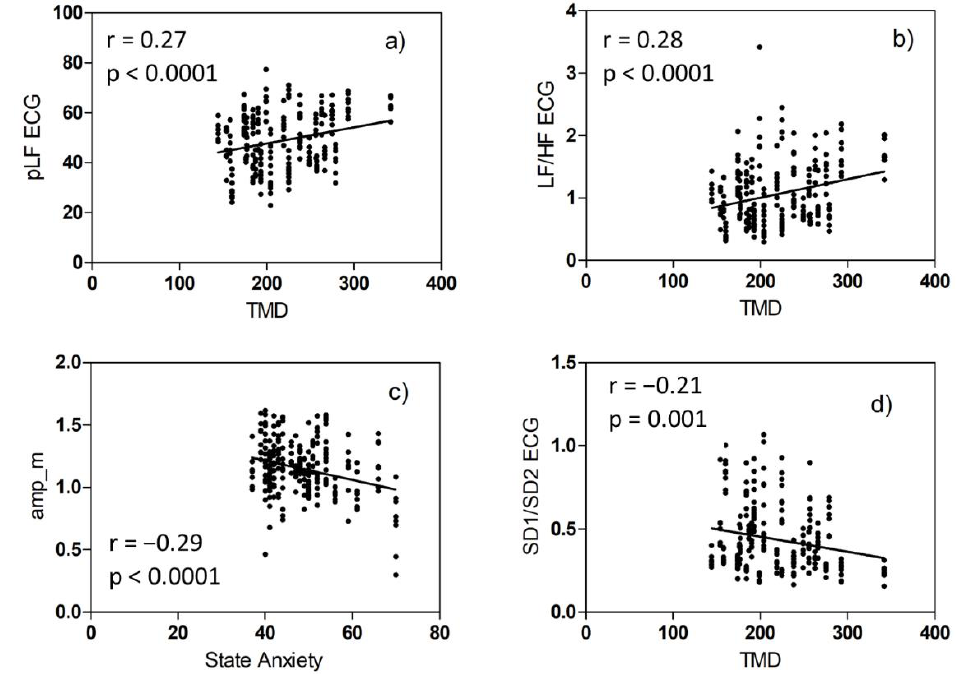
Figure 10. Correlation plots of HRV or SP values and TMD or STAI − Y values: ( a ) pLF ECG, ( b ) LF/HF ECG, ( c ) amp_m, ( d ) SD1/SD2 ECG.